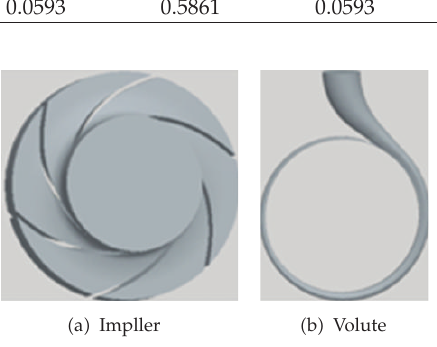
Figure 7: Models for mesh